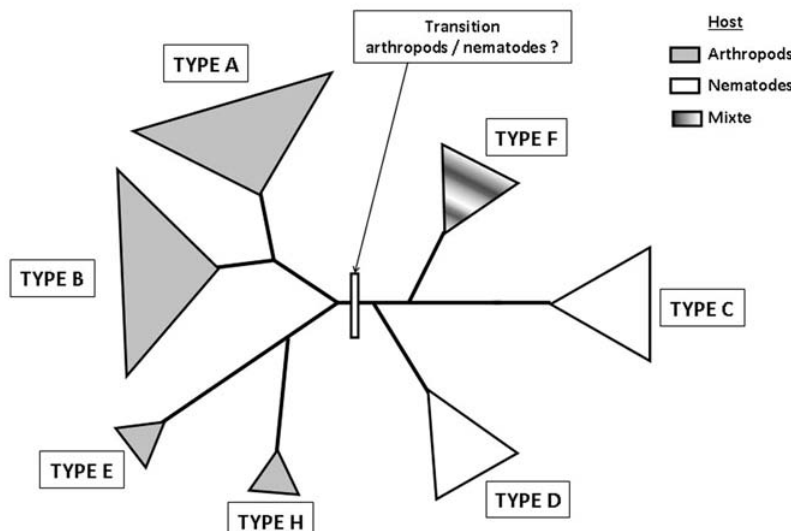
Fig. 2. – Wolbachia supergroup phylogeny, adapted from (Werren et al. , 2008). the eight established supergroups are represented. type C and D are specific of filariae; type F is shared by filariae and